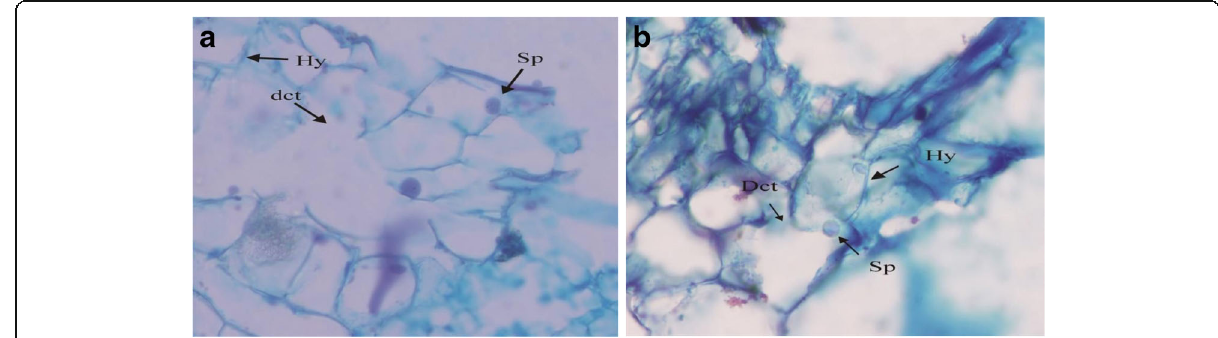
Fig. 5 a Histopathological interaction of Phythium ultimum with roots tissue of tomato plants (longitudinal section, 40 ×). b Histopathological interaction of Phytopthora capsici with roots tissue of tomato plants (longitudinal section, 40